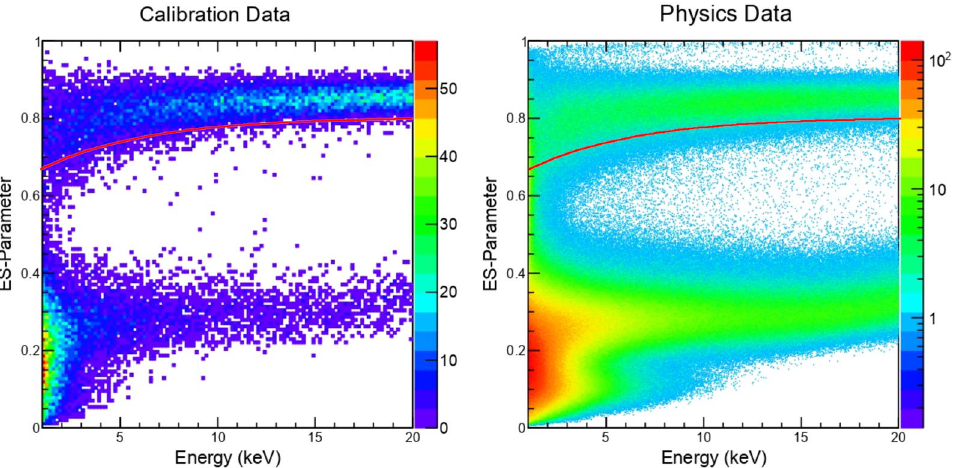
60 Co calibration data of the multiple-